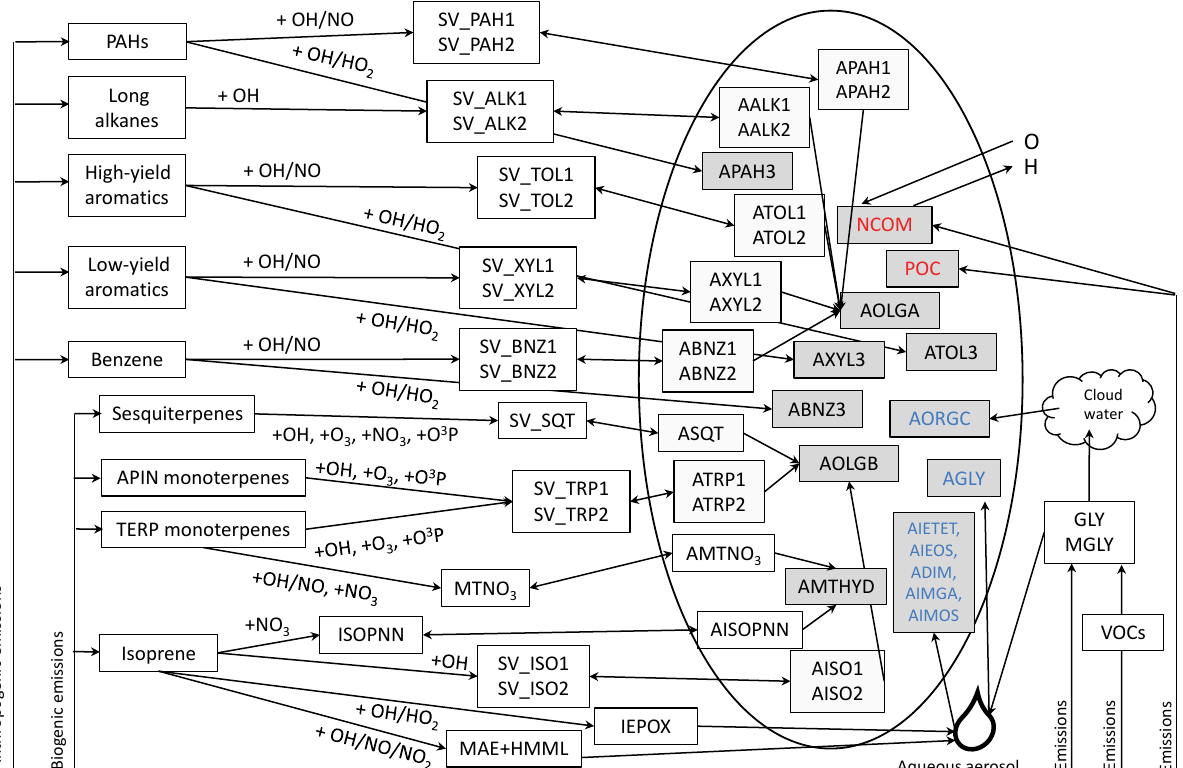
Figure 3. Schematic of SOA treatment in current CMAQ-aero6i. Species are described in Table 1. Species in grey boxes are nonvolatile. Species with names in red make up POA (i.e., POA = POC + NCOM, where POC stands for primary organic carbon and NCOM stands for non-carbon organic matter). Species with names in blue form in the model as a direct result of interactions with